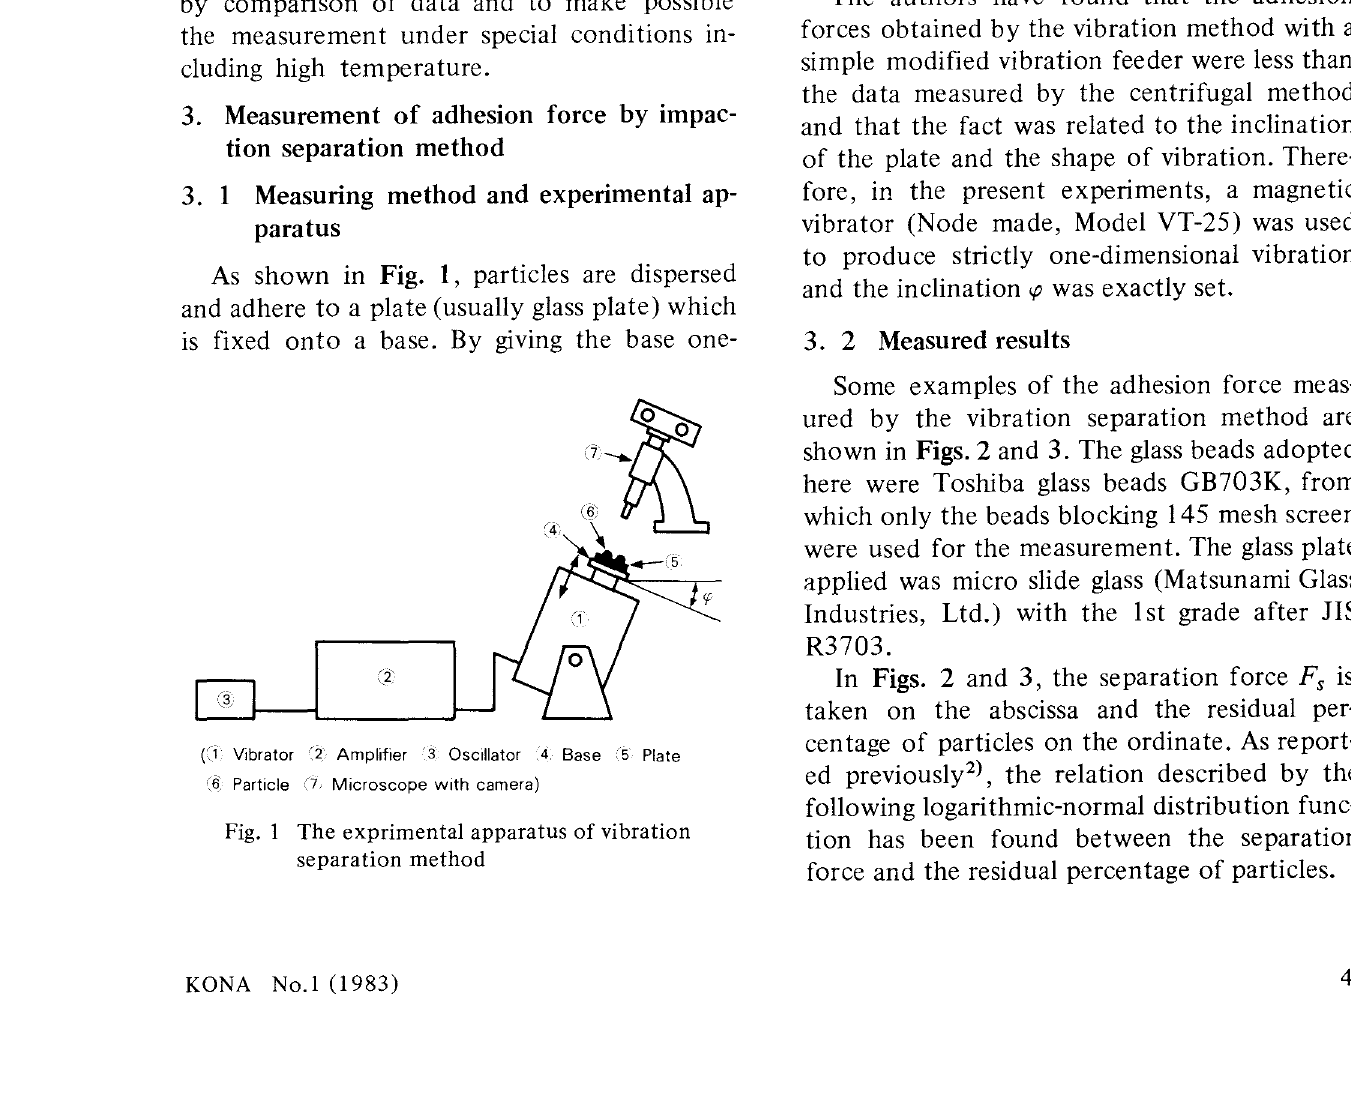
Fig. 1 The exprimental apparatus of vibration separation